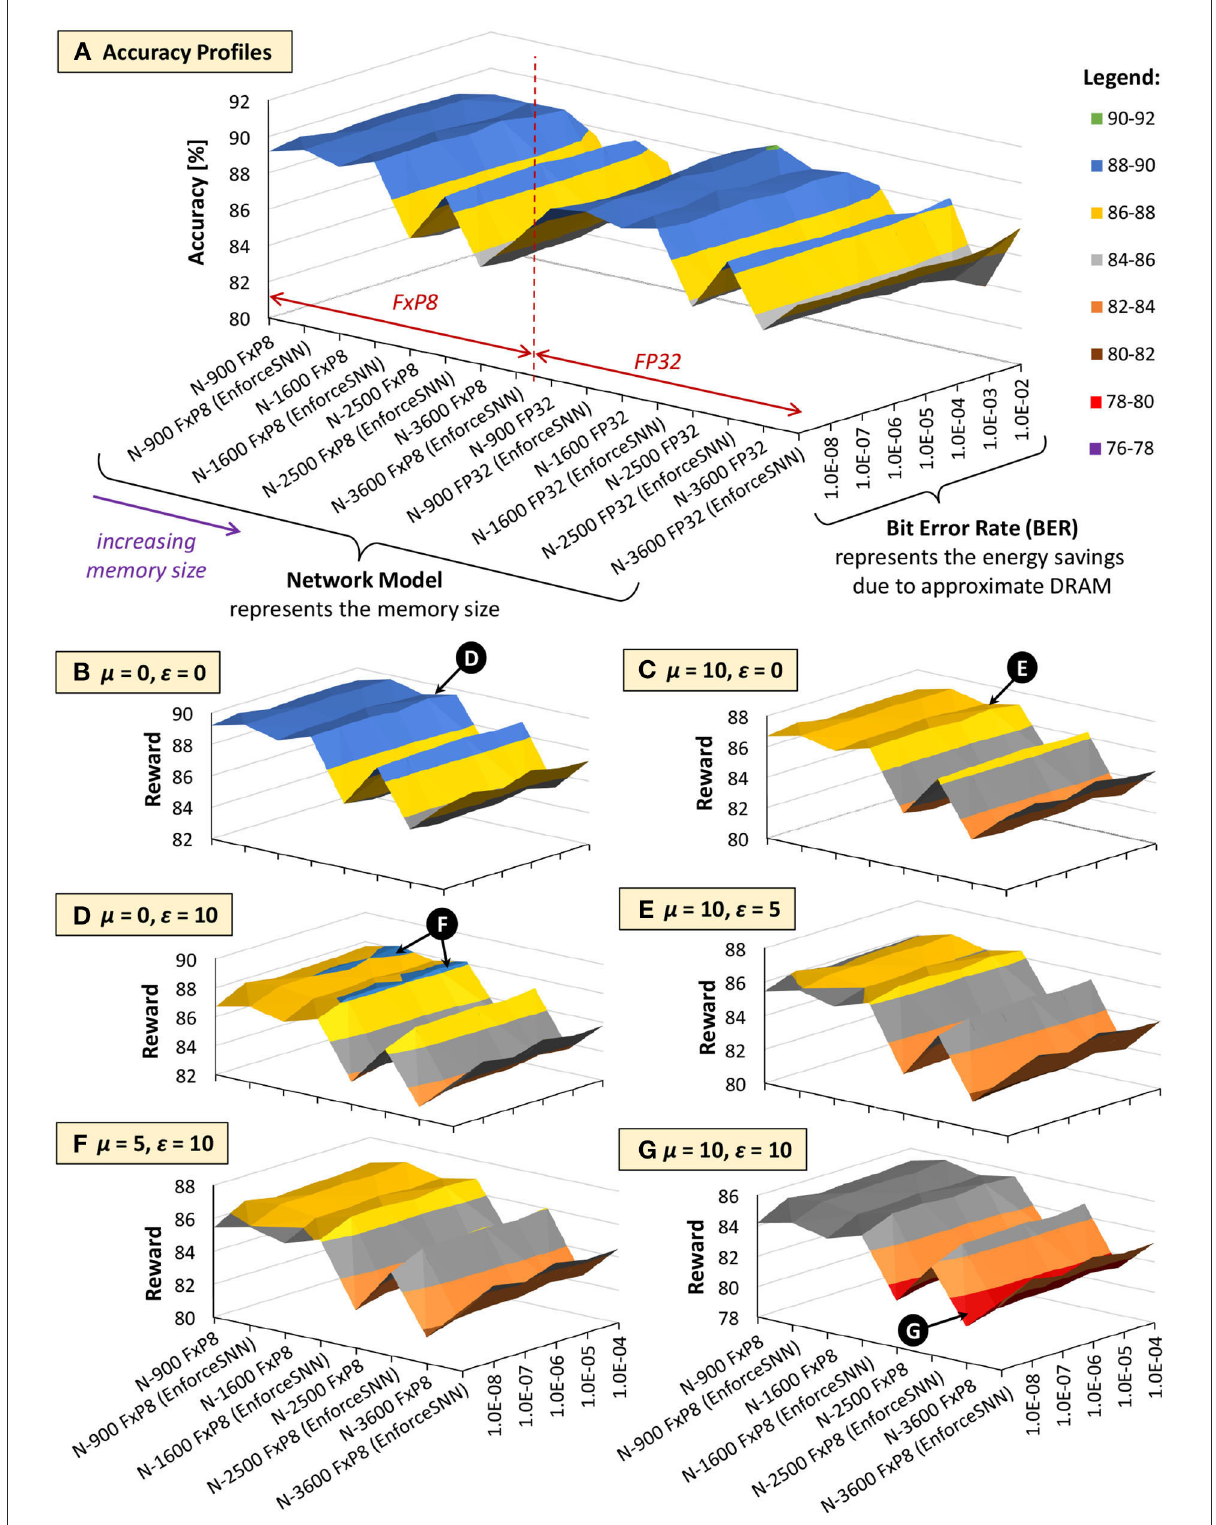
FIGURE13 The trade-offs among accuracy, memory footprint, and energy consumption for the MNIST. (A) Accuracy profiles of SNN models. (B–G) Reward profiles of SNN models. The network sizes represent the memory sizes and the BER values represent the energy savings from approximate